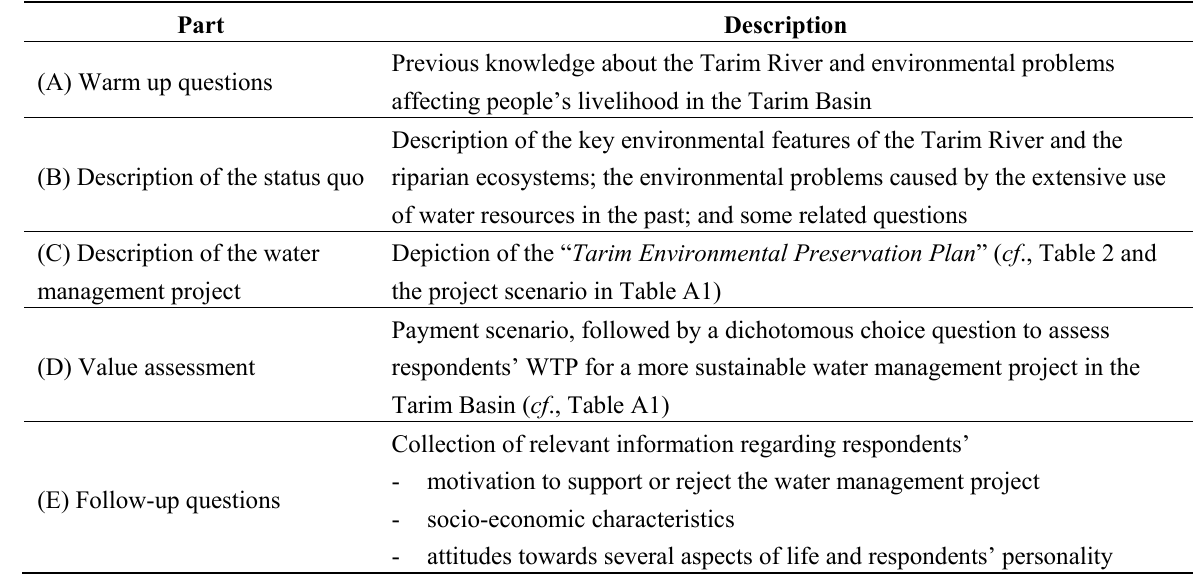
Table 1. Description of the contingent valuation method (CVM)